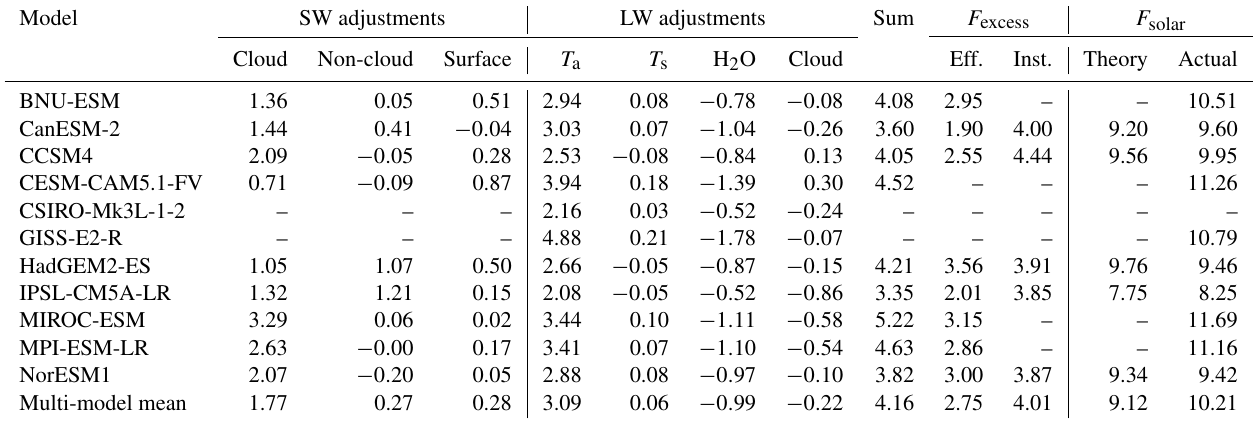
Table 3. Global mean radiative adjustments in G1 – piControl, and excess and total solar forcing in G1, in Wm − 2 . Positive values indicate a warming effect (increase in absorbed SW radiation or decrease in OLR), except for solar forcing where positive values represent a cooling. SW adjustments correspond to multi-model means plotted in Fig. 7. LW adjustments correspond to multi-model means plotted in Figs. 8 and 9, with the sign flipped for Fig. 8. “Sum” is the sum of all the SW and LW adjustments. F excess is calculated using Eq. (6) and represents the actual instantaneous solar forcing ( F solar ) in G1 minus that which would match the CO 2 effective or instantaneous forcing. F solar represents the total instantaneous solar forcing calculated from theory (Eq. 8) or actually used in G1 (Eq.